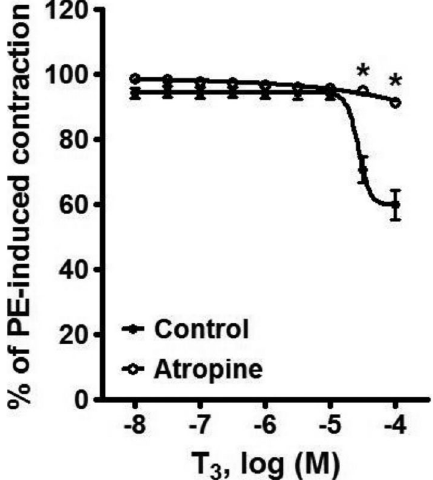
Figure 2. Pre-incubation with 10 -6 M atropine blocked the vasorelaxation produced by higher concentrations of T 3 in phenylephrine (PE)-precontracted rat aortic rings. Data are reported as means ± SE (n=8). *P o 0.05 vs control (two-way